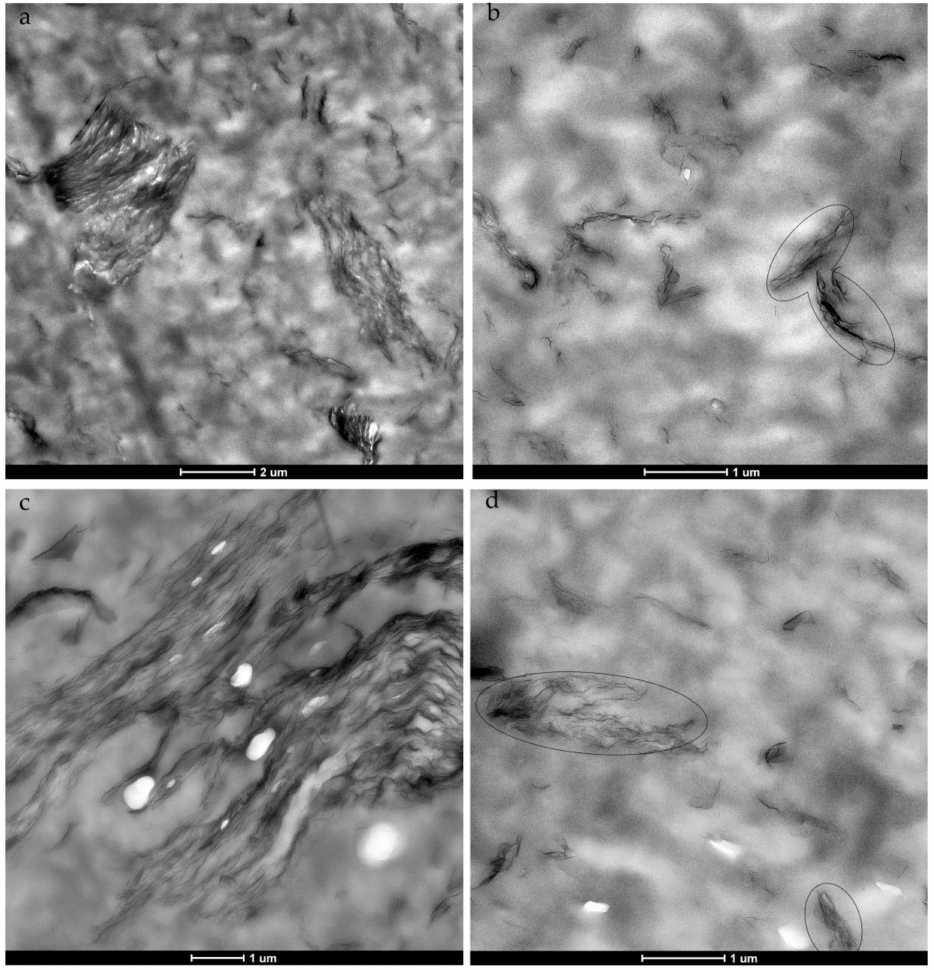
Figure 2. TEM micrographs of the bTPU-3 GR ( a , b ) and bTPU-3 GR-IL ( c , d ) NCs, obtained with low (left) and high (right) magnifications. Some graphene stacks have been highlighted with a circle in figures